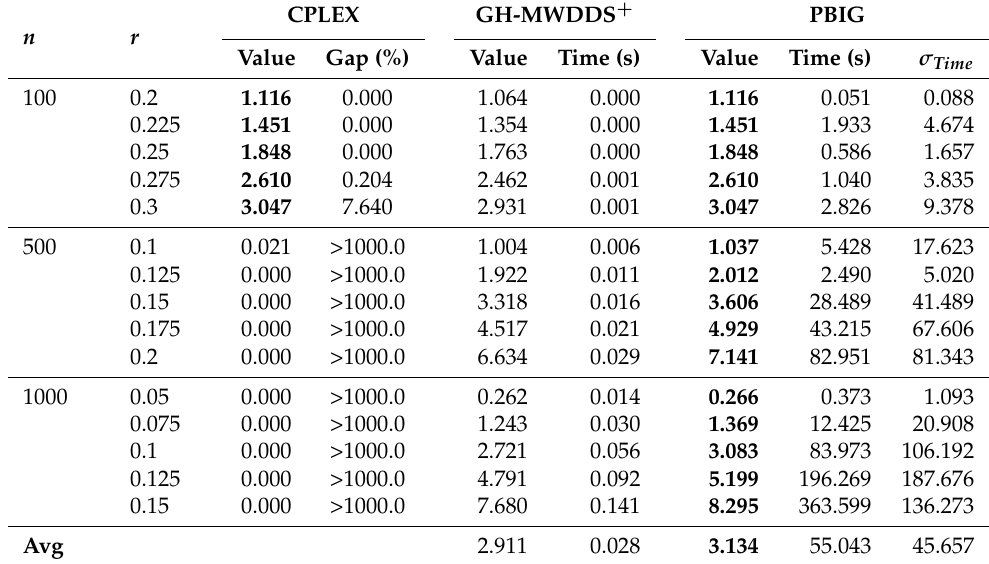
Table 3. Numerical results for the instances of S ET 2 (random geometric